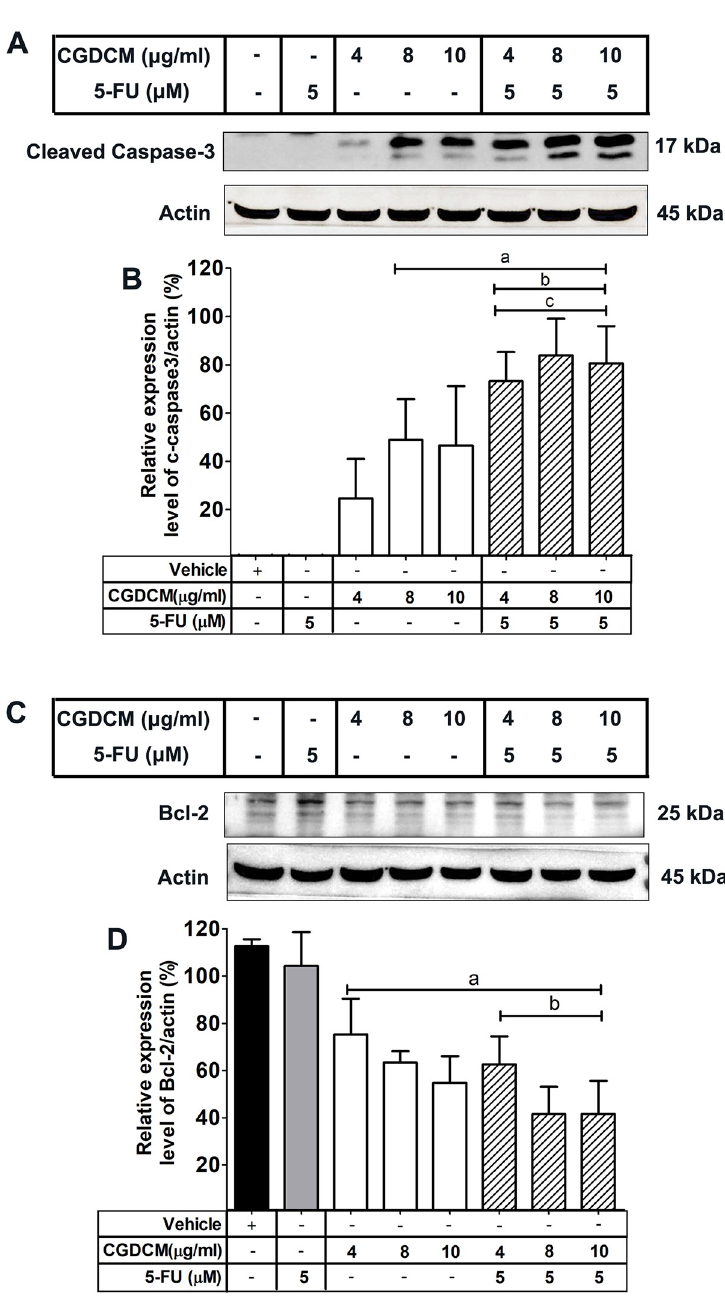
Fig 5. Effects of CGDCM and 5-FU on the expression of apoptosis proteins in HCT116 cells. The protein expression levels in HCT116 cells treated with CGDCM, 5-FU, and combinations of CGDCM (4, 8, and 10 μ g/mL) with 5-FU (5 μ M or 0.65 μ g/mL) for 24 h, were analyzed by western blotting ( A − D ). The data are presented as mean ± SD, and were analyzed by one-way ANOVA with Tukey’s HSD test. a; p < 0.05 vs. vehicle group. b; p < 0.05 vs. 5-FU group. c; p < 0.05 vs. treatment with CGDCM alone. Abbreviations: CGDCM, C . gigantea dichloromethane extract; 5-FU, 5-fluorouracil; Bcl-2, B-cell lymphoma